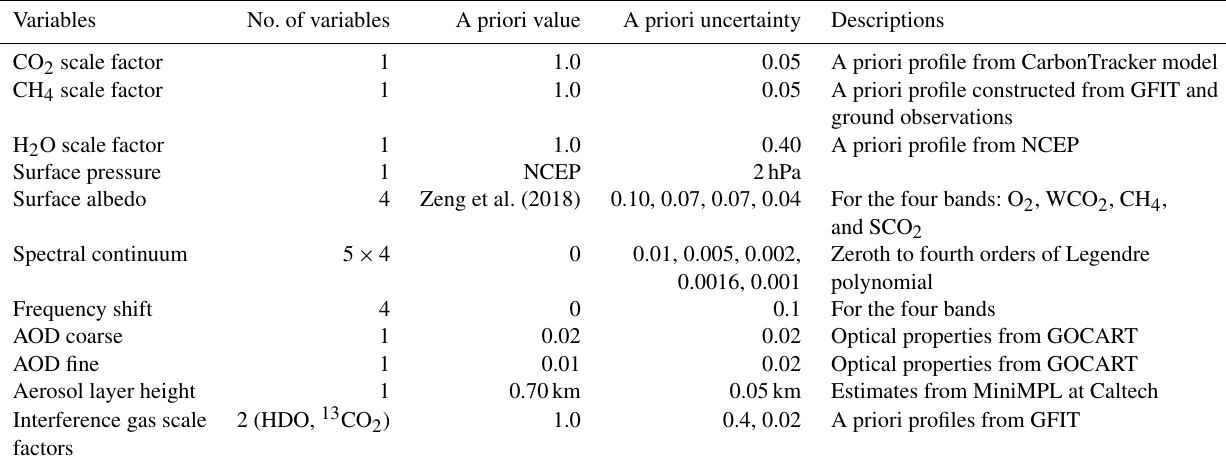
Figure 4. Ratio of the difference (relative to the continuum value) between simulated radiances (using O-PCA) and high-accuracy com- putations (using LIDORT with 32 streams). These calculations are based on the 240 scenarios, with different observation geometries and atmospheric profiles, described in the inverse experiments in Sect. 4. Four empirical orthogonal functions are used for the O-PCA compu- tations. Three different aerosol scenarios are considered, with AOD values of 0.01, 0.05, and 0.1 in the 1.27µm O 2 1 (cid:49) band. The overall RMSEs are also indicated. Table 1. Summary of variables in the state vector and their